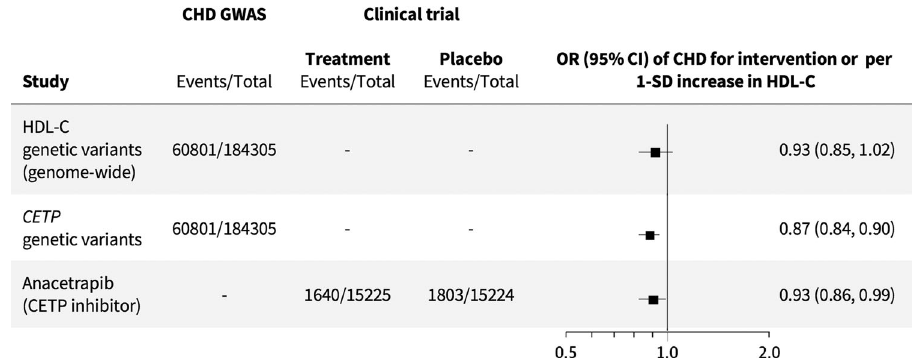
Fig. 1 HDL-C, CETP inhibitor, and CHD: genome-wide biomarker vs. drug target MR. Forest plot of the HDL-C biomarker MR estimate (Holmes et al., 2015), drug target MR estimate of CETP level and function using HDL-C as a proxy (Schmidt et al., 2020), and odds ratio of anacetrapib clinical trial (HPS3/TIMI55 – REVEAL Collaborative Group, 2017). OR odds ratio, CI con fi dence interval, SD standard